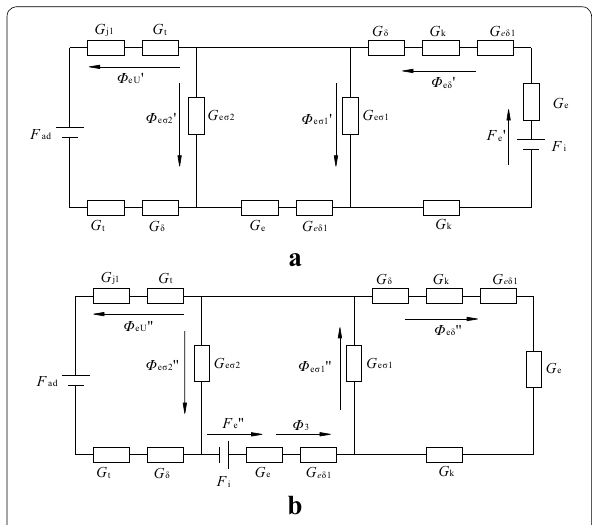
Figure 13 Electrical excitation equivalent magnetic circuit model superposition principle diagram. a Model a of electrical excitation part equivalent magnetic circuit. b Model b of electrical excitation part equivalent magnetic circuit